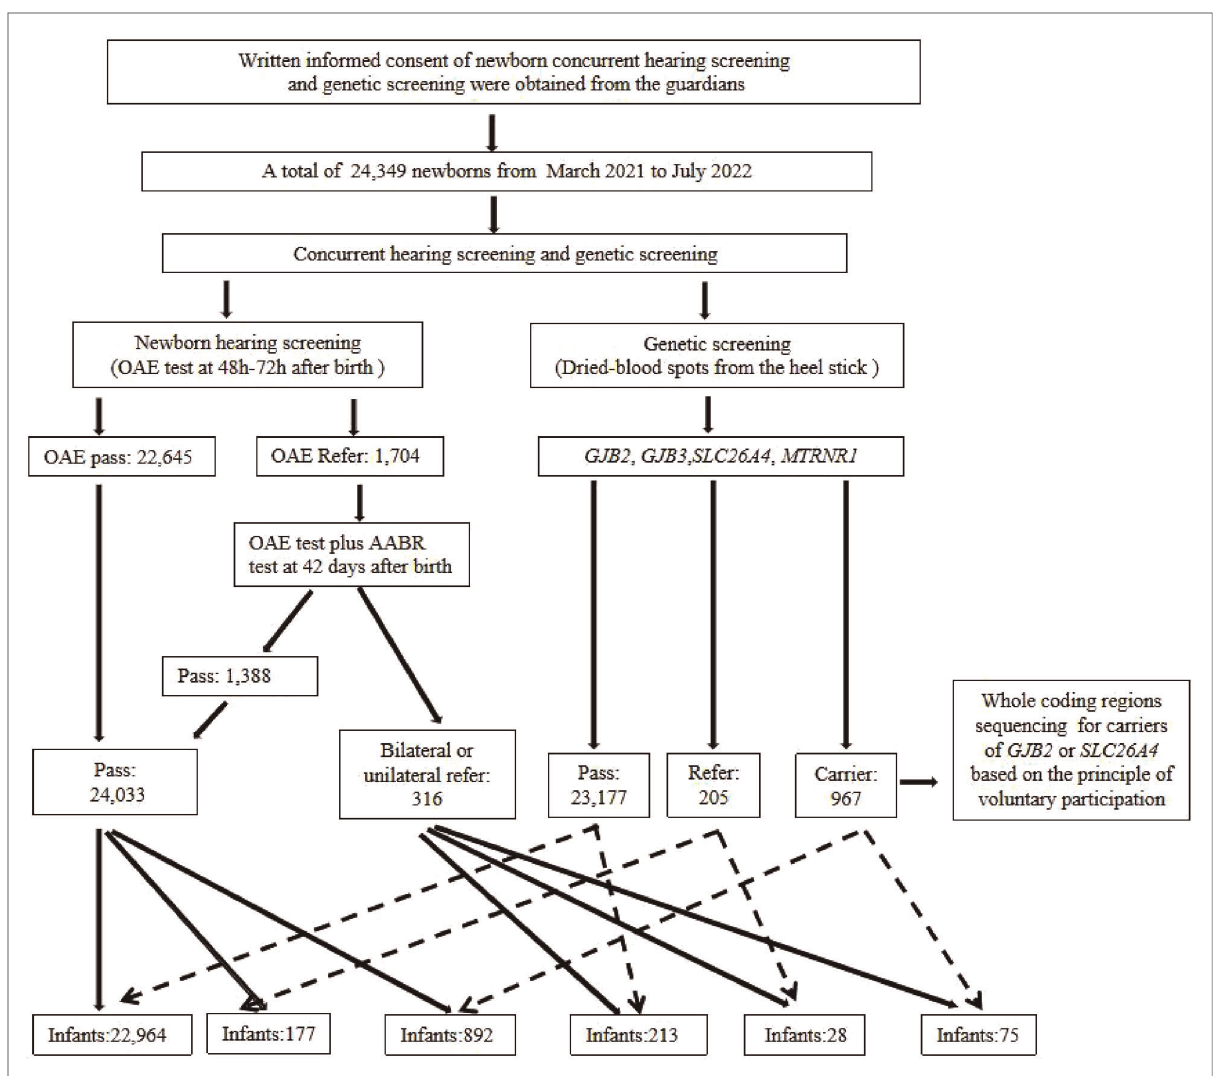
FIGURE 2 Comprehensive analysis and associations between the newborn hearing screening and genetic screening in this study. AABR, automatic auditory brainstem repose; OAE, otoacoustic emission.